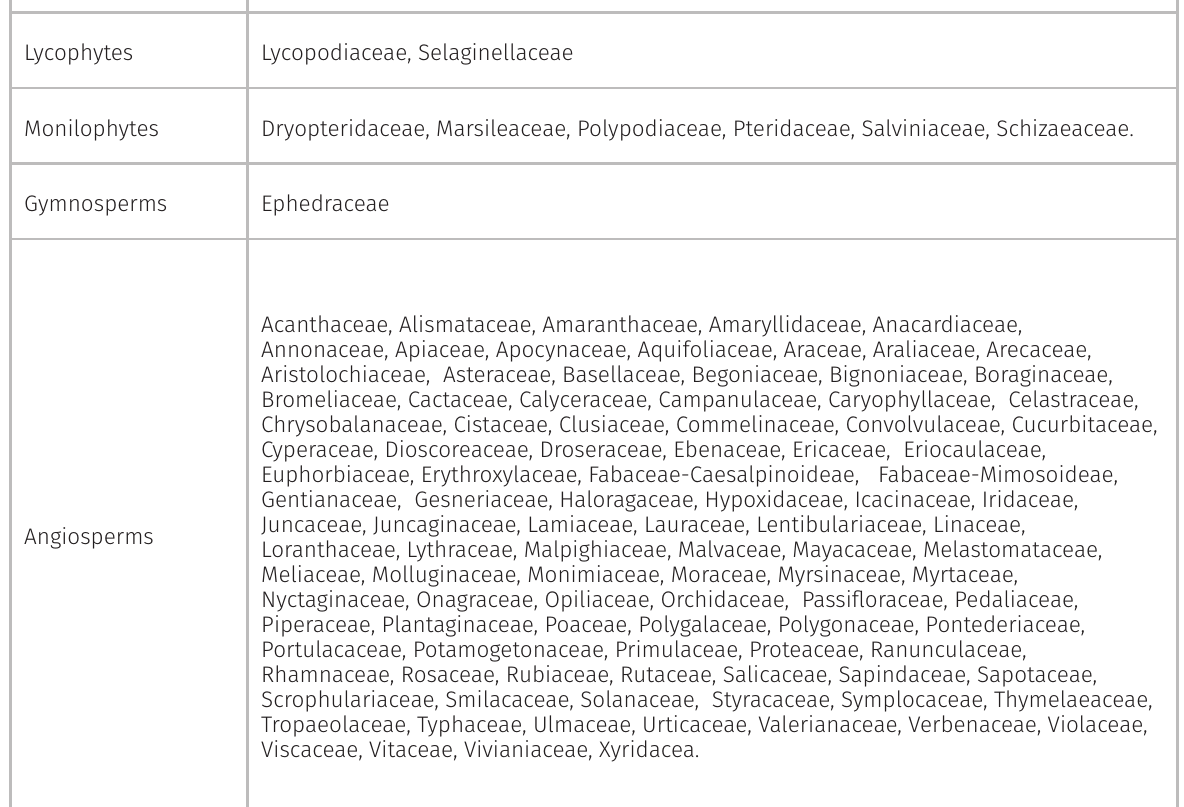
Table Ι. Botanical list of the Itapuã State Park, based on Antonio (1996), Scherer et al. (2005, 2007). Botanical Survey